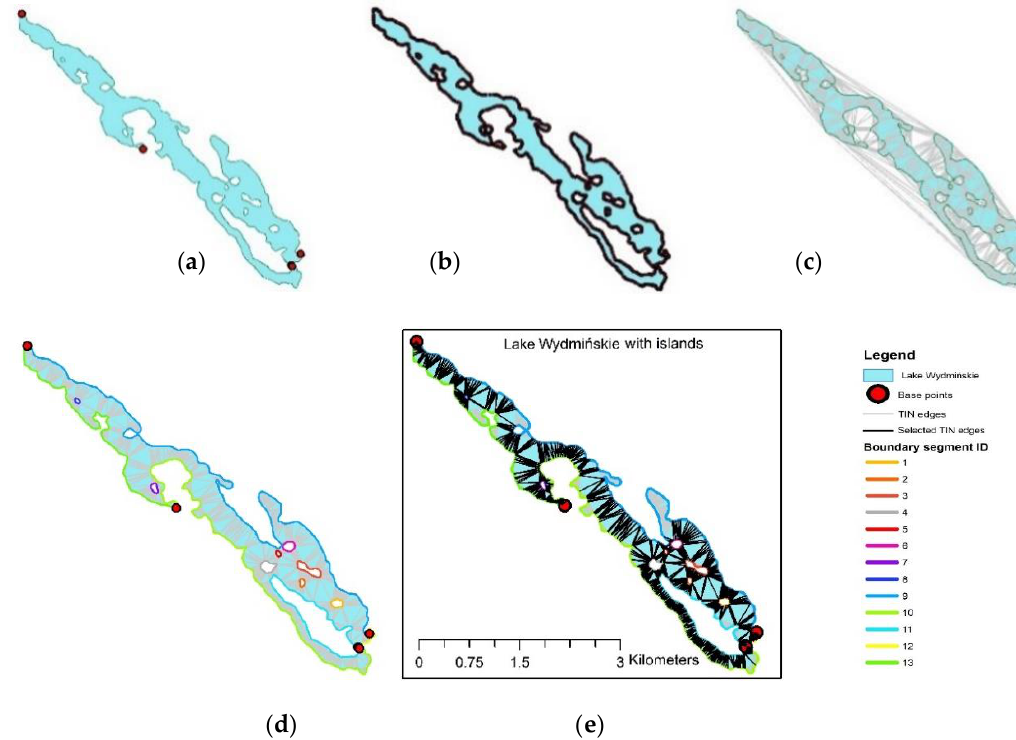
Figure 23. Data transformation in the skeleton generation process: ( a ) location of base points, ( b ) vertices of a complex polygon representing the analyzed lake; ( c ) generated TIN edges; ( d ) TIN edges inside the complex polygon representing the analyzed lake, with a visualization of boundary segments; ( e ) process visualization, with an indication of the TIN edges selected for skeleton generation.